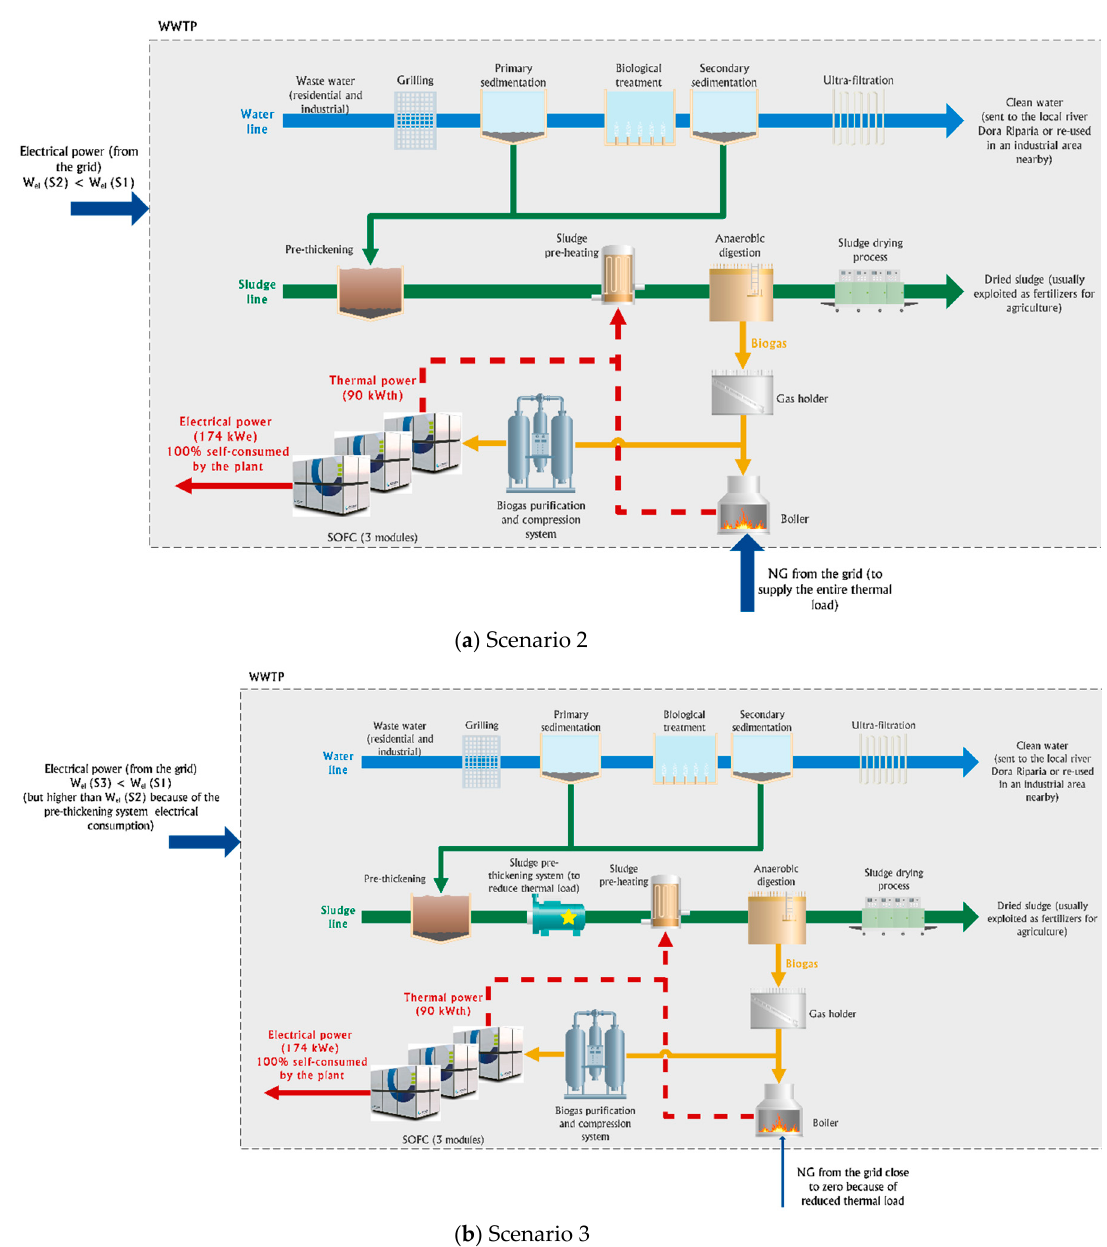
Figure 3. Biogas and sludge lines in the scenarios ( ( a ) Scenario 2 and ( b ) Scenario 3) with SOFC based CHP system.